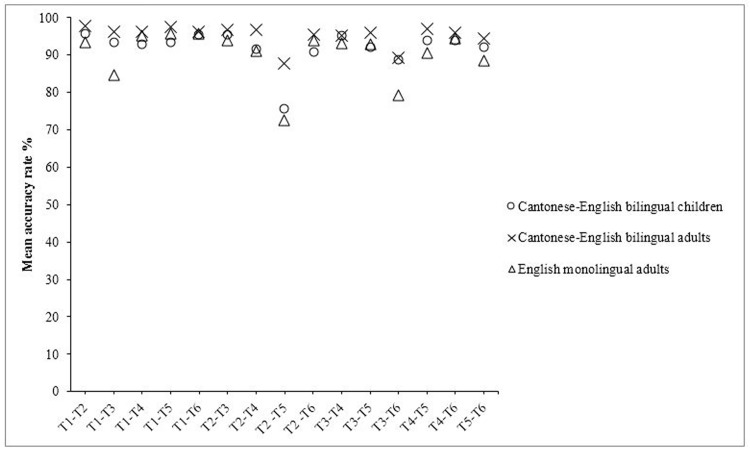
Mean Percentages of correct response for all 15 tone contrasts for all three groups.